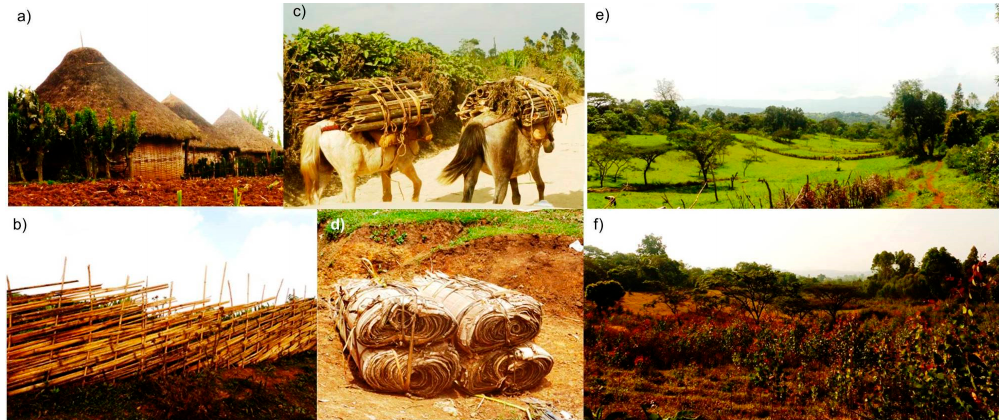
Figure 6. Farmers’ use of timber and non-timber products from bamboo forest, and grazing land conversion to eucalyptus plantation in the Gera landscape of Ethiopia. Domestic and market demand for timber and non-timber products from bamboo forest: houses ( a ) and fence constructed from bamboo ( b ), dried bamboo used as firewood ( c ), and bamboo bark as cover for locally made beehives ( d ). Grazing land converted to eucalyptus plantation by a group of farmers in Kerebe village, Sadi Loya kebele ( e and f ). Photos taken before and after the conversion: ( e ) on 19 October 2013 and ( f ) on 9 January